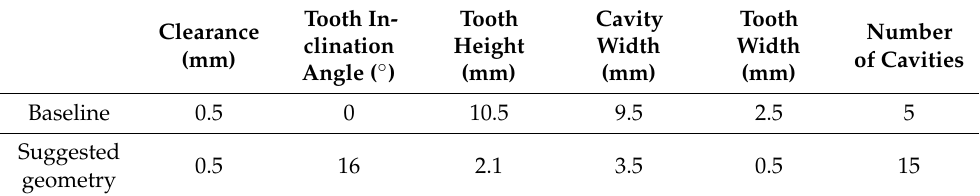
Table 5. The baseline and suggested optimal geometrical parameters.